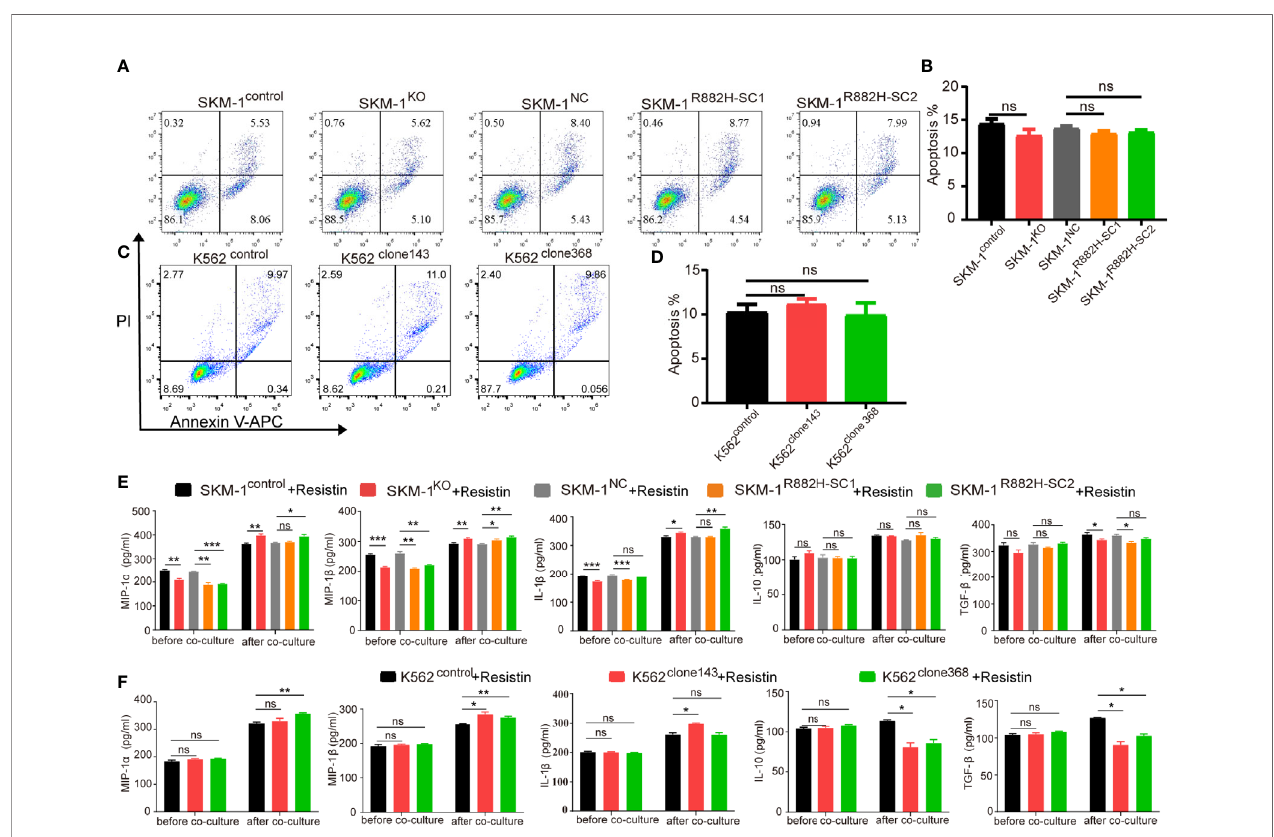
FIGURE 7 | DNMT3A mutated AML cells regulate the macrophage phenotype by suppressing transcription factors AP-1. (A – D) Representative dot plots and column diagram showing the apoptosis rate of AML cells treated with resistin after the co-culture with M1 macrophages. (E, F) The secretion of in fl ammatory factors in the supernatant of macrophages and resistin-treated AML cells was measured by ELISA. All the results are presented as mean ± standard deviation of three independent experiments (n = 3). *p < 0.05, **p < 0.01, and ***p < 0.0001 represent signi fi cant differences compared with the control. ns, no signi fi